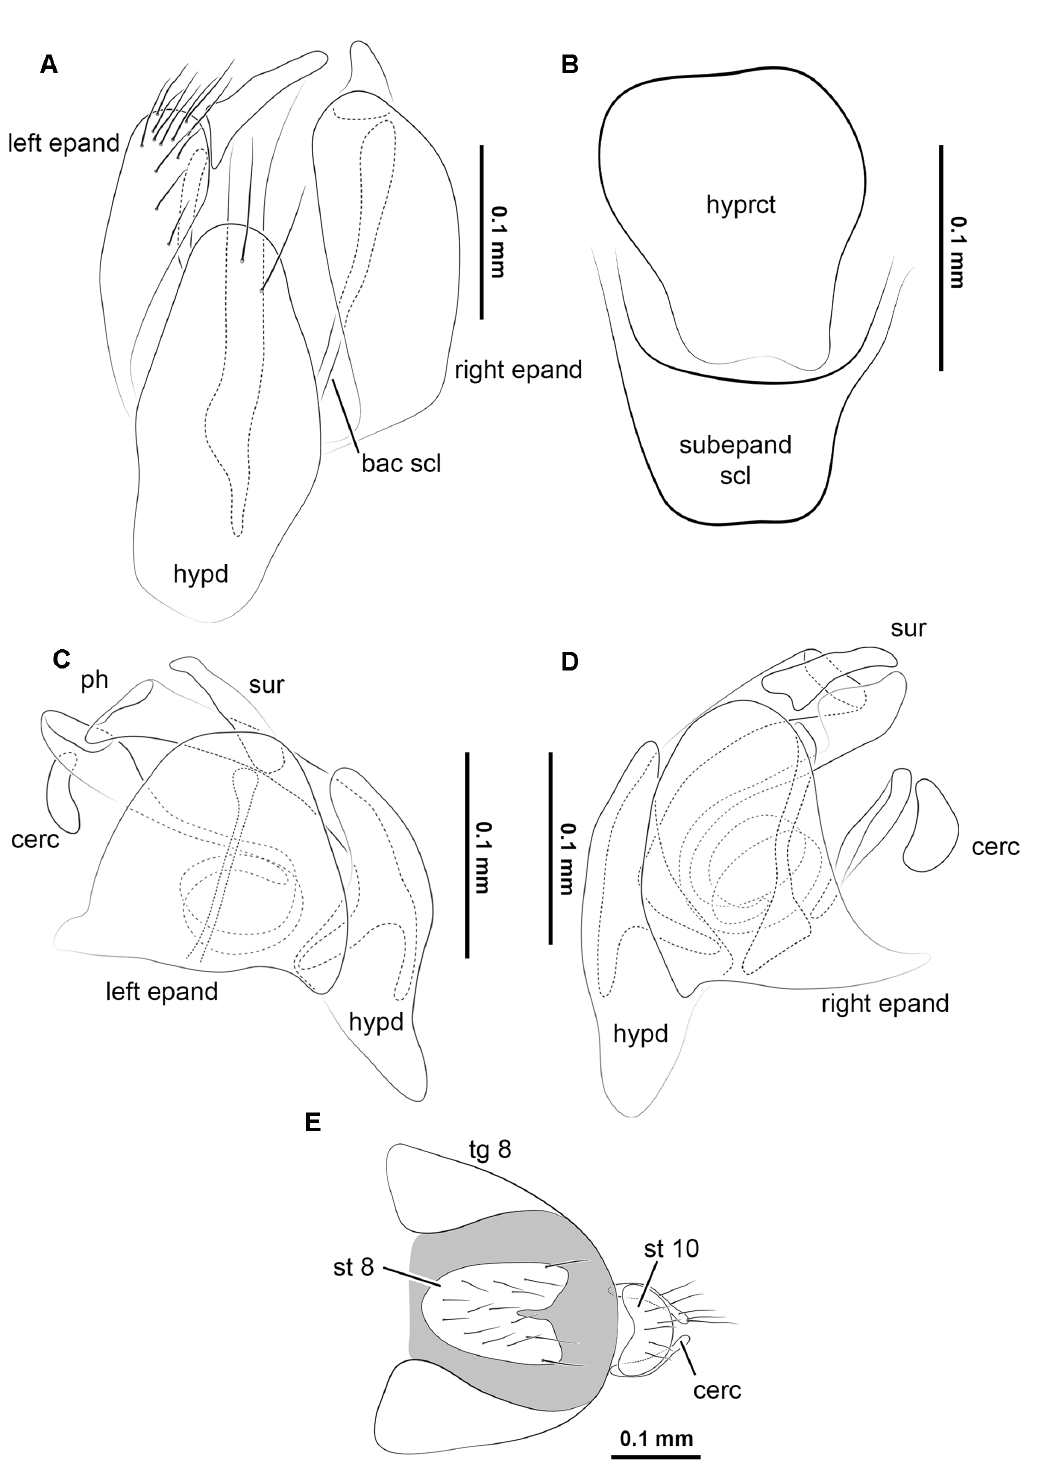
Fig. 2. Chvalaea australis sp. nov. A–D . Male terminalia, holotype (AMS). A . Ventral view. B . Dorsal view. C . Left lateral view. D . Right lateral view. E . Female terminalia, paratype (AMS), ventral view. Abbreviations: bac scl = bacilliform sclerite; cerc = cercus; epand = epandrium; hypd = hypandrium; hyprct = hypoproct; ph = phallus; st = sternite; subepand scl = subepandrial sclerite; sur = surstylus; tg =